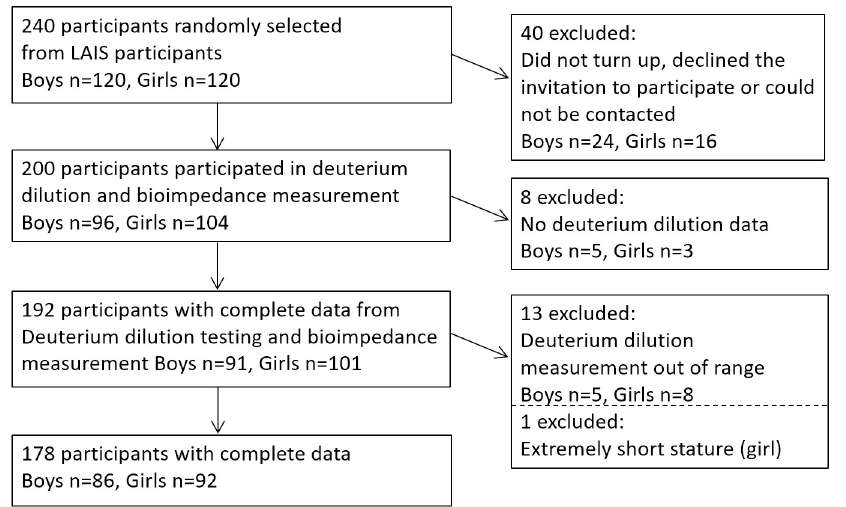
Fig 1. Flow chart. LAIS, Lungwena Antenatal Intervention